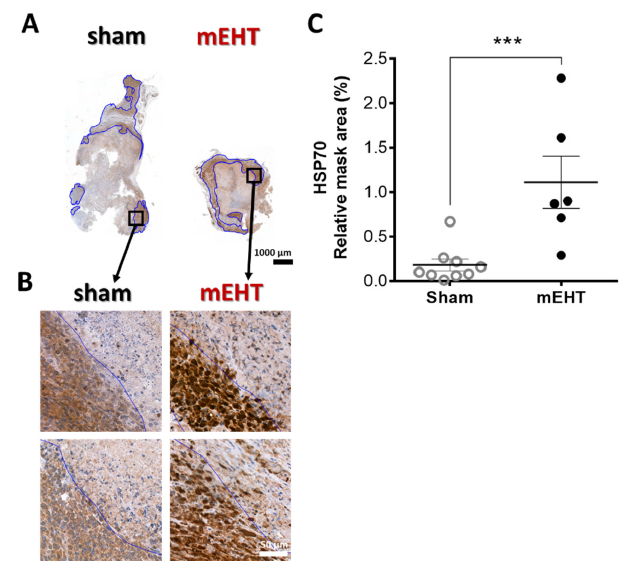
Figure 3. Effect of mEHT treatment on Hsp70 expression 24h after the 5th mEHT treatment. Representative tumors from sham and mEHT-treated mice with Hsp70 staining (0.9 × magnification), black rectangles magnified at ‘B’ ( A ). Representative sections of Hsp70 expression near the damaged tumor area (blue annotation), 40 × magnification ( B ). Expression of Hsp70 evaluated in the intact tumor tissue (blue annotations) significantly increased in mEHT-treated tumors ( C ). In one case, TDR appeared to be 100% and no living area remained to be evaluated for Hsp70 expression. Mean ± SEM, Mann-Whitney test, n = 6–9/group, ***: p < 0.001. Cell line: 4T07, 5 × treated.